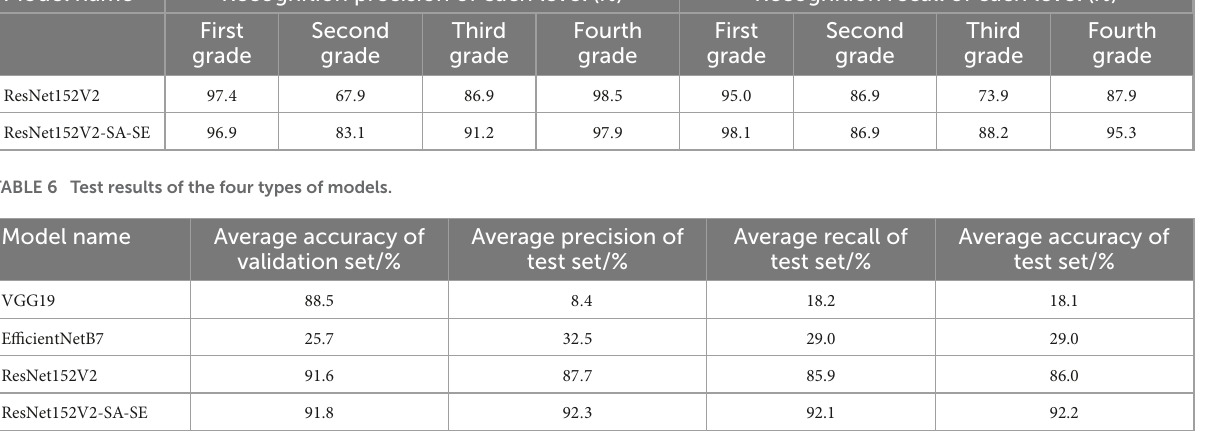
TABLE 5 Test results of the SA-ResNet152V2 model and ResNet152V2-SA-SE model. Model name